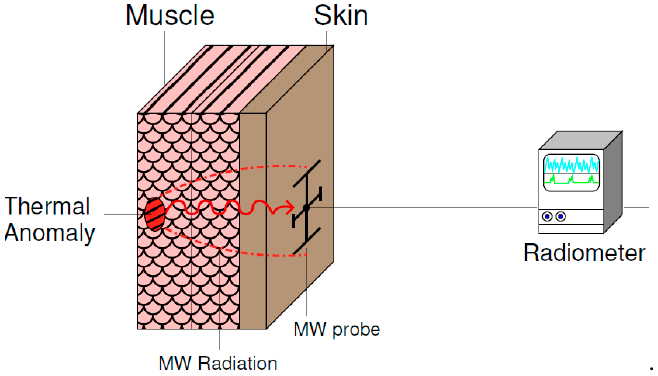
Figure 1. Scheme of the proposed MMR measurement set-up.